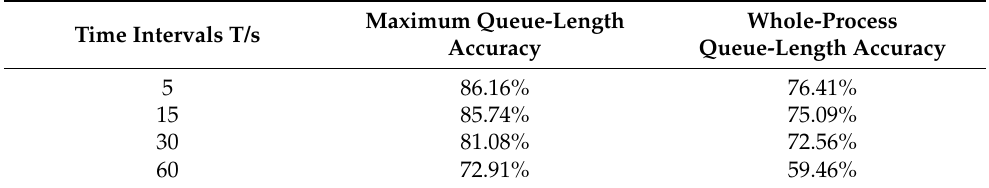
Table 5. Comparison of accuracy of different time intervals after smoothing with a window length of 30 s.